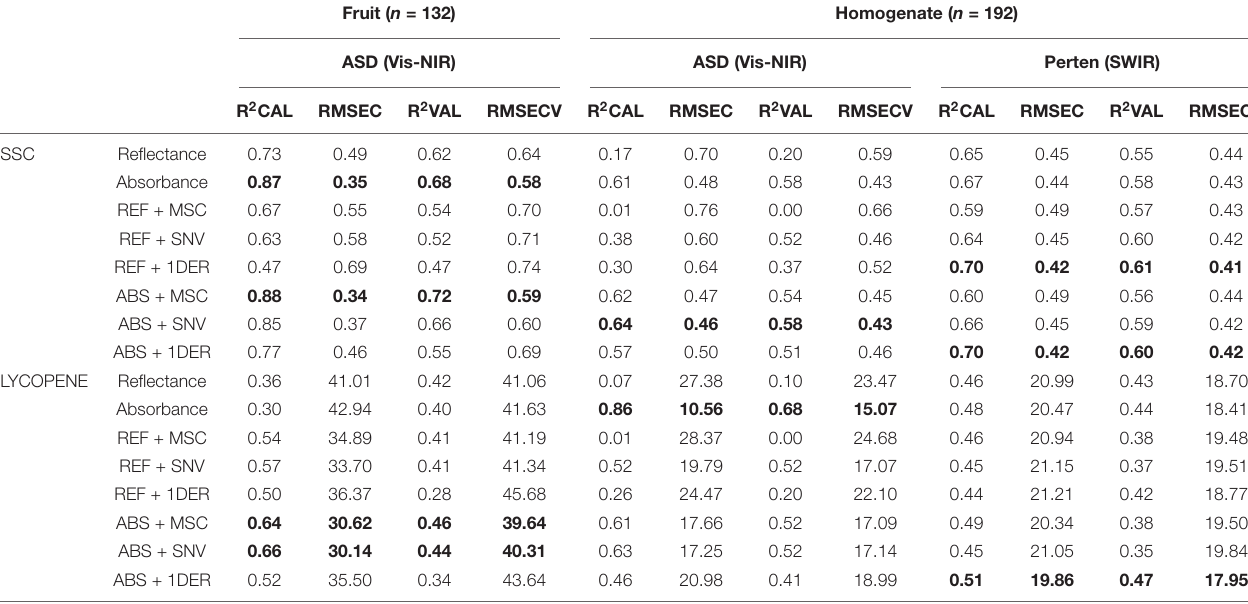
TABLE 1 | Predictive capability of calibration models for SSC and lycopene content of tomato samples by ASD and Perten spectrometers. Fruit ( n = 132) Homogenate ( n = 192) ASD (Vis-NIR) ASD (Vis-NIR) Perten (SWIR)